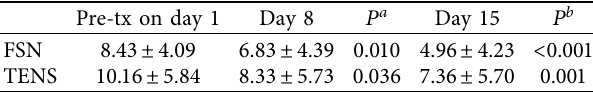
Figure 7: Comparison the short-term and long-term effects of the two groups. The value of VAS (a), PPT (b), and TH (c) was measured on day 1 before treatment and followed up to day 8 and day 15 in both groups. Asterisks ( ∗ ) and hashtag ( # ) showed the P < 0 . 05 in FSN or TENS group, respectively. VAS: visual analog scale, PPT: pressure pain threshold, TH: tissue hardness, PFG: pain free grip, FSN: Fu’s subcutaneous needling, and TENS: transcutaneous electrical nerve stimulation. Table 4: Short-term and long-term effects of FSN and TENS groups on NDI.